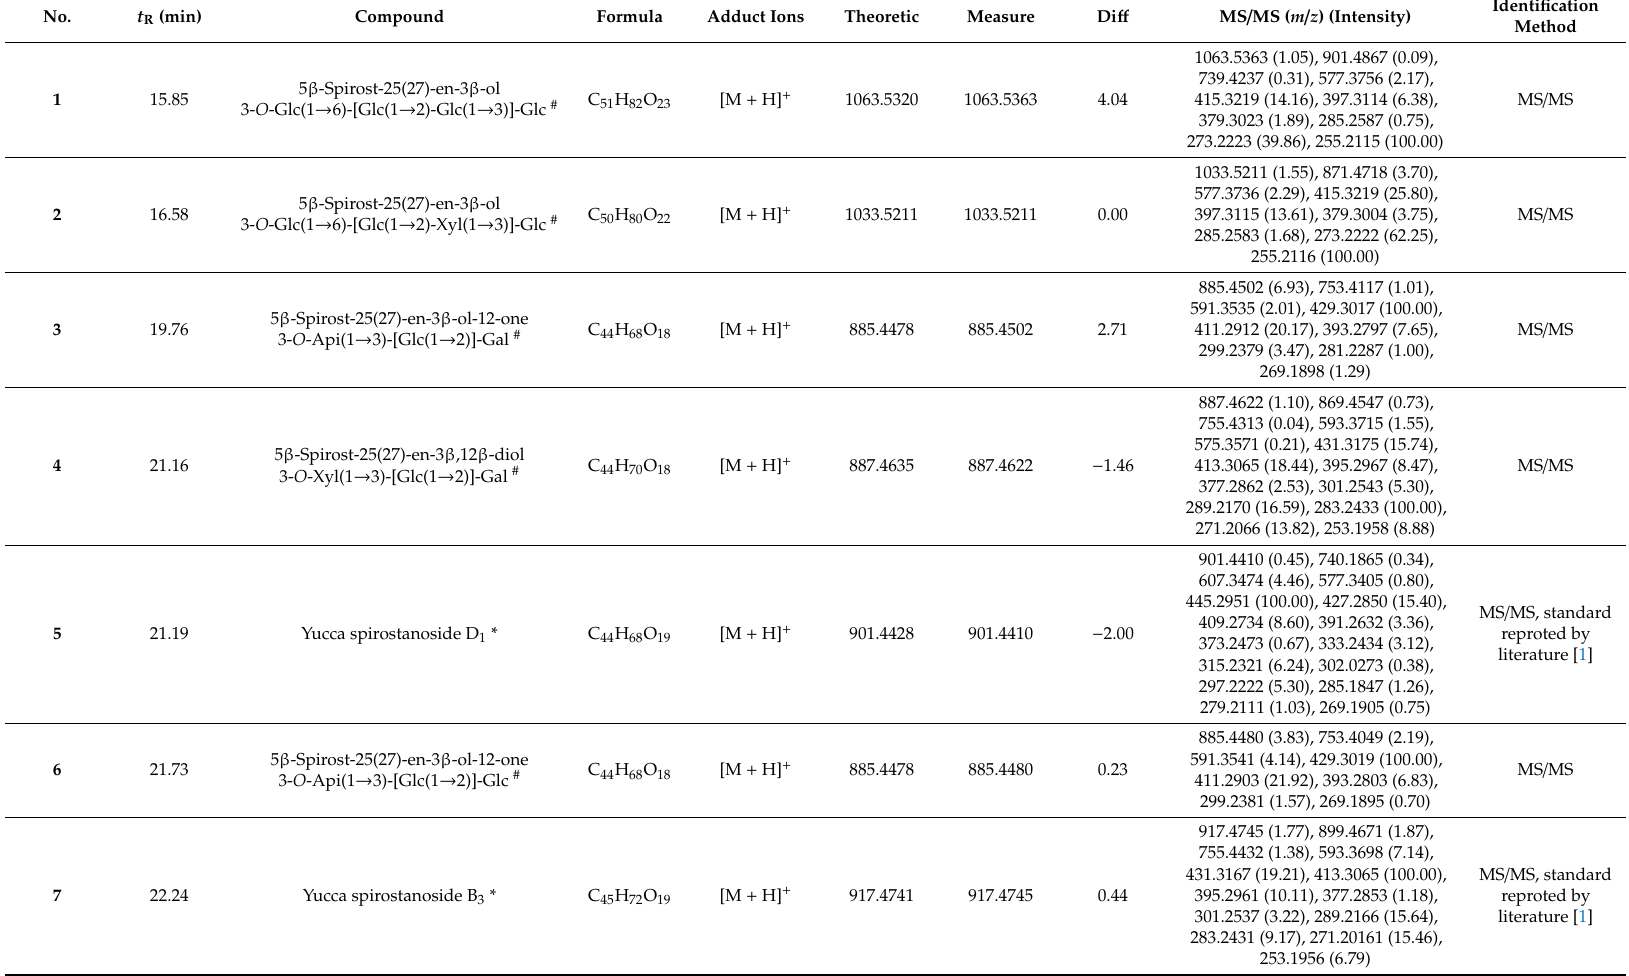
Table 1. The qualitative analysis of compounds 1 – 110 by ESI-Q-Exactive-Orbitrap